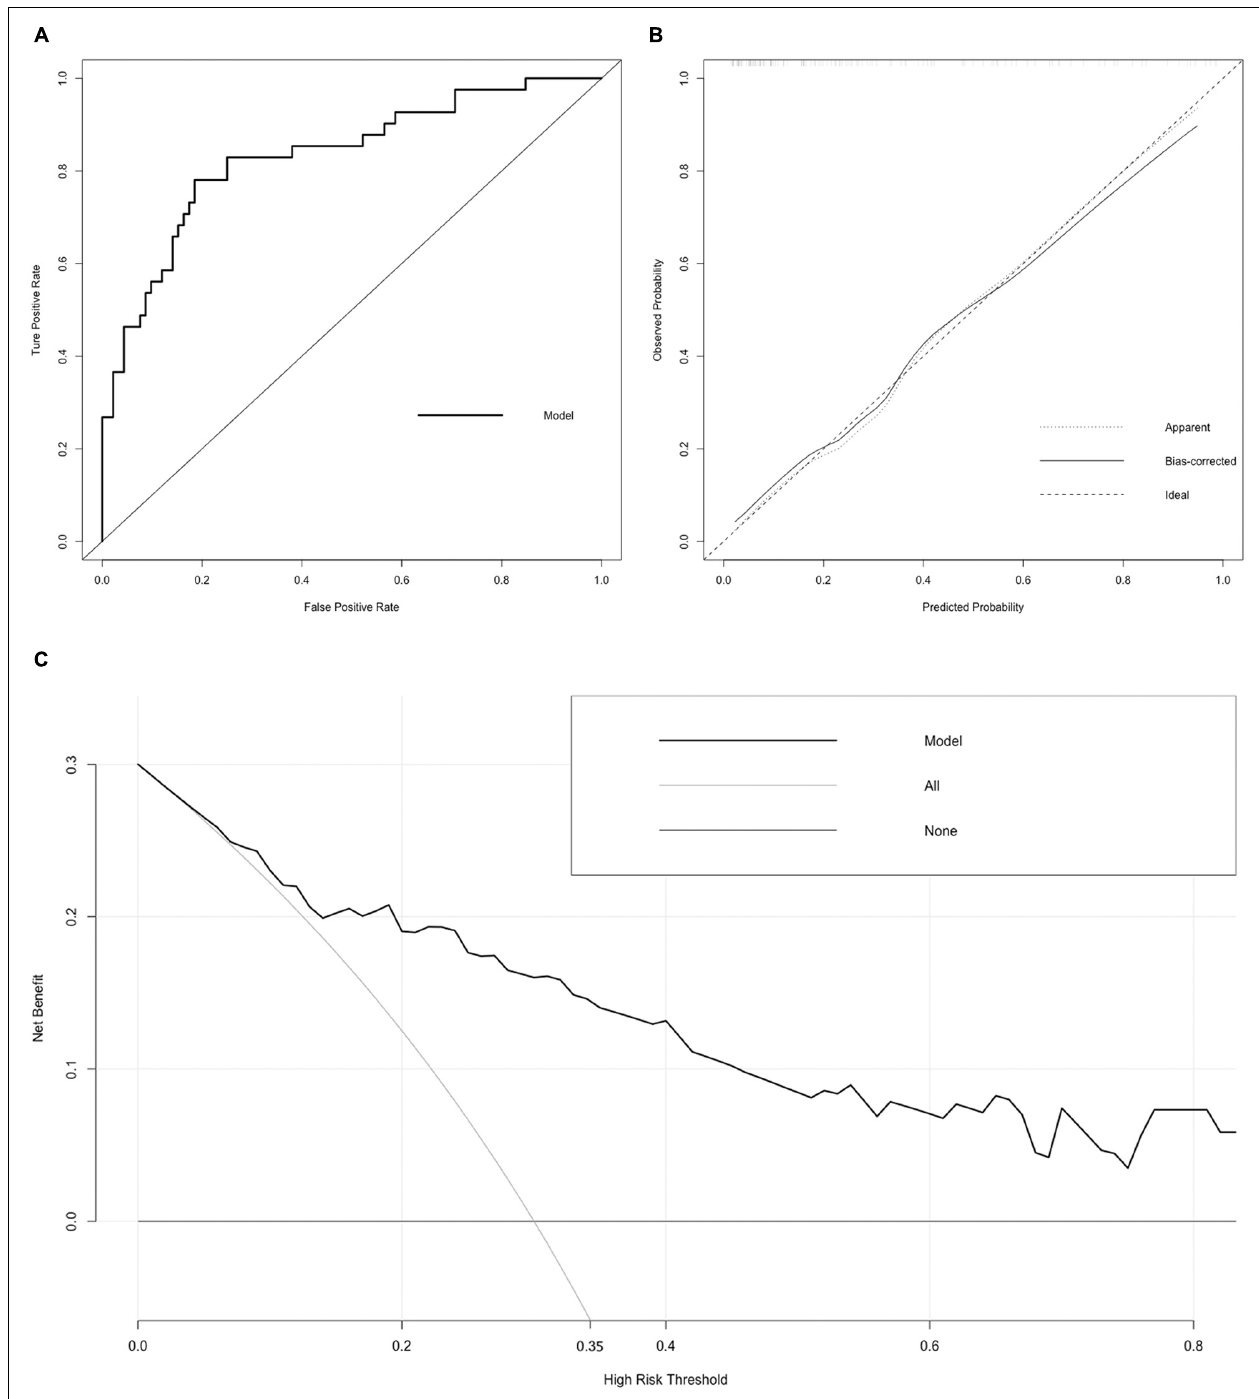
FIGURE 3 | Receiver operating characteristic (ROC) curve, calibration curve, and DCA curve of the nomogram. (A) ROC curve. The AUC of the nomogram was 0.834 (95% CI = 0.755–0.912). (B) Calibration curve. The black dotted line represents the ideal reference line, where the predicted probability matches the observed probability. The solid line is calculated by bootstrapping (resampling: 1,000) and represents the performance of nomogram. The closer the solid line is to the black dotted line, the more accurate the model predicts the incidence of LACR. (C) DCA curve. The dark black dotted line indicates that assuming that all patients do not have LACR, the net benefit rate is 0. The light black dotted line indicates that assuming that LACR occurs in all patients, the net benefit rate is a backslash with a negative slope, and the “high risk” threshold is 0.35. The solid line is the decision curve the nomogram, reflecting the relationship between threshold probability and net benefit. The closer the curve is to the upper right, the greater the net benefit under the same threshold probability. ROC curve, receiver operating characteristic curve; AUC, area under curve; CI, confidence interval; LACR, late-onset acute cellular rejection; DCA, decision curve analysis.